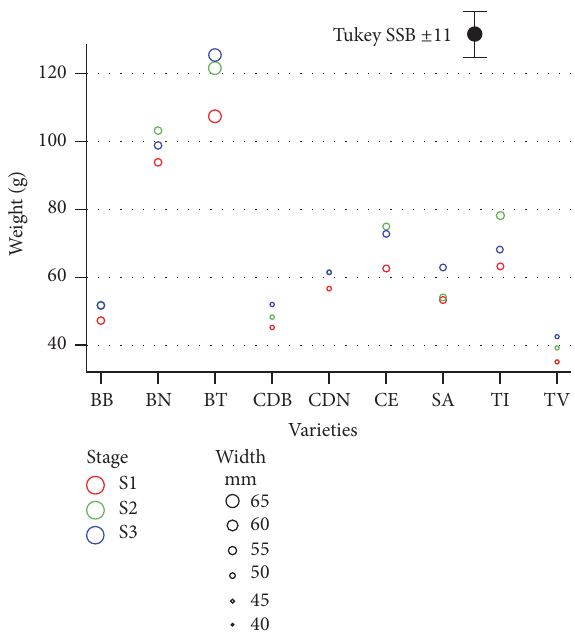
Figure 1: Weight and width of the brebas of nine fig tree varieties grown in Extremadura. BB: Blanca B´etera; BN: Banane; BT: Brown Turkey; CDB: Cuello Dama Blanco; CDN: Cuello Dama Negro; CE: ColarElche;SA:SanAntonio;Ti:Tiberio;TV:TresVoltasL’Any.SSB: statistical significance bar using the Tukey HSD